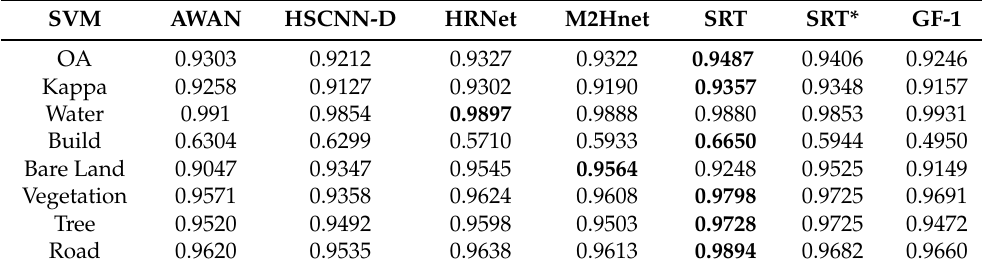
Table 9. Accuracy of classification result of Area3 with SVM. The best results are shown in bold. SVM